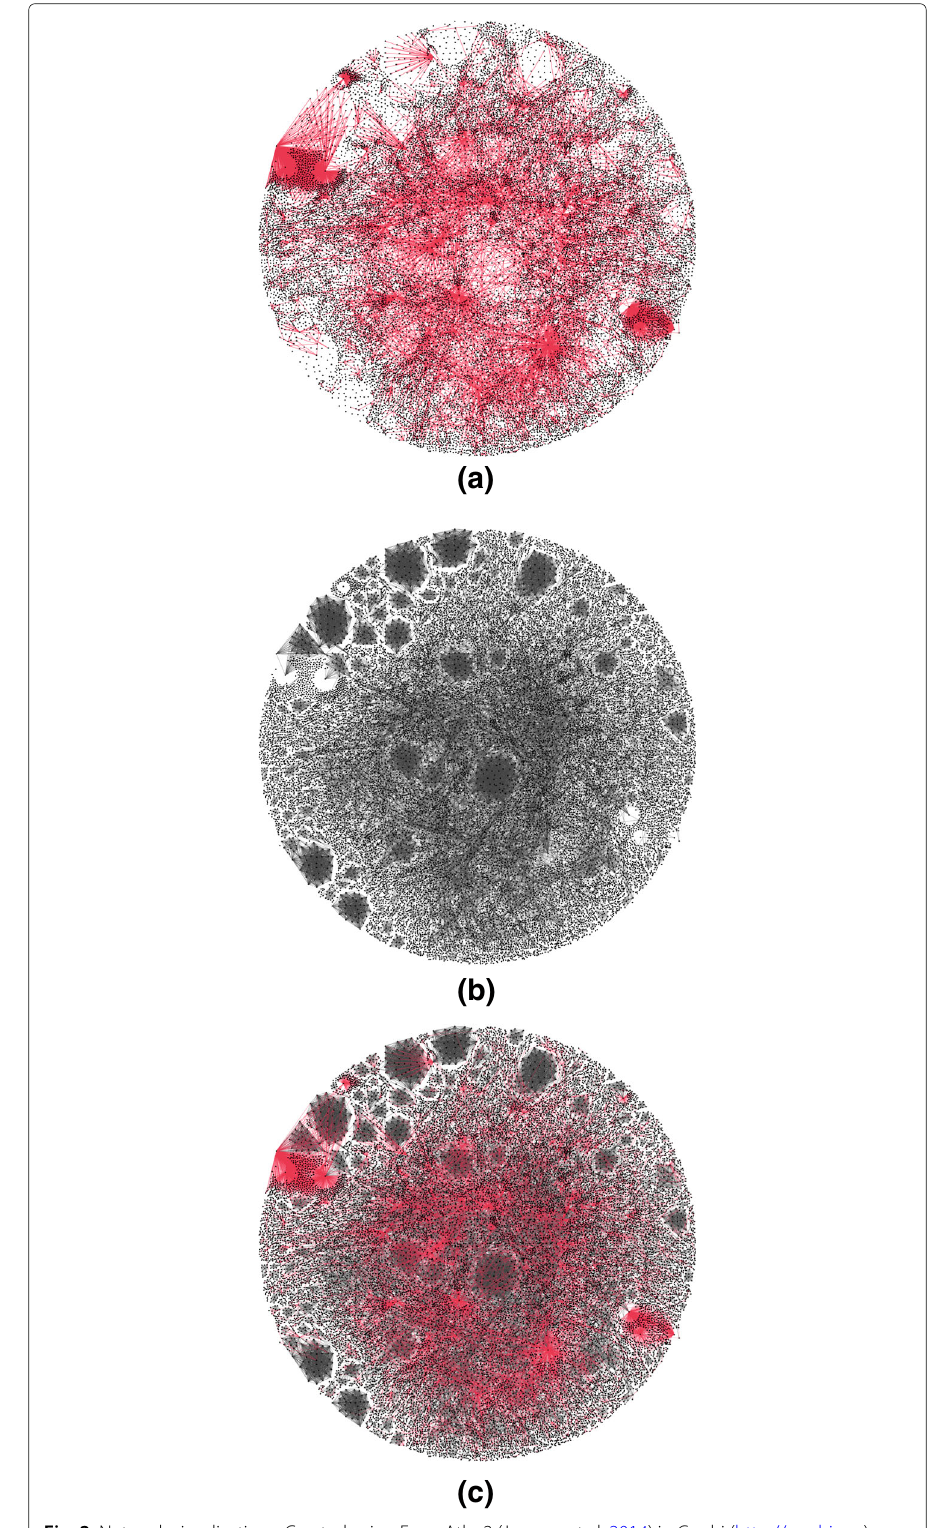
Fig. 2 Network visualizations. Created using ForceAtlas2 (Jacomy et al. 2014) in Gephi (http://gephi.org) using the “stronger gravity” option. a Ownership network, b Board interlock network, c Multiplex